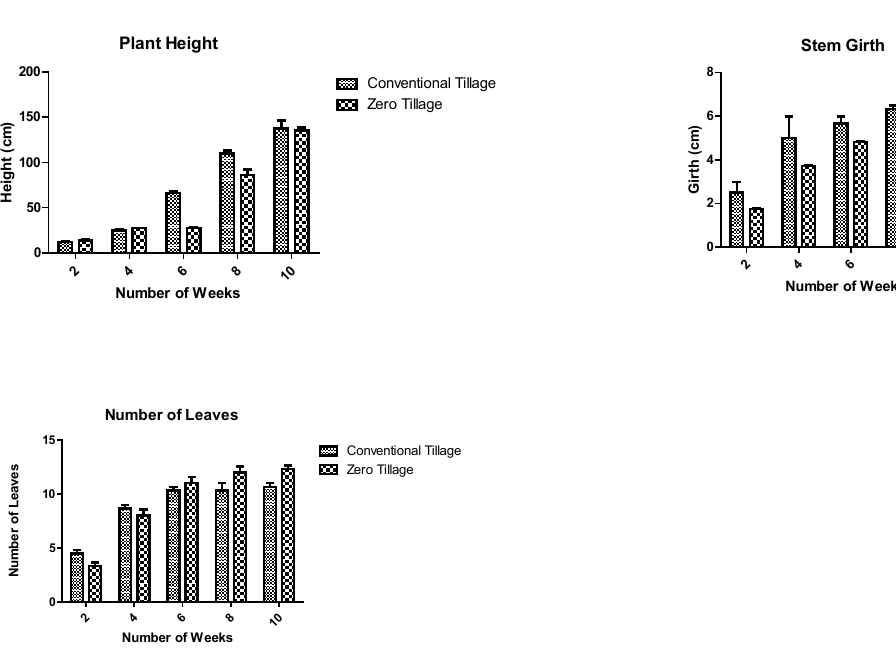
Figure 3: Growth Parameters under Different Tillage Practices during Early Season